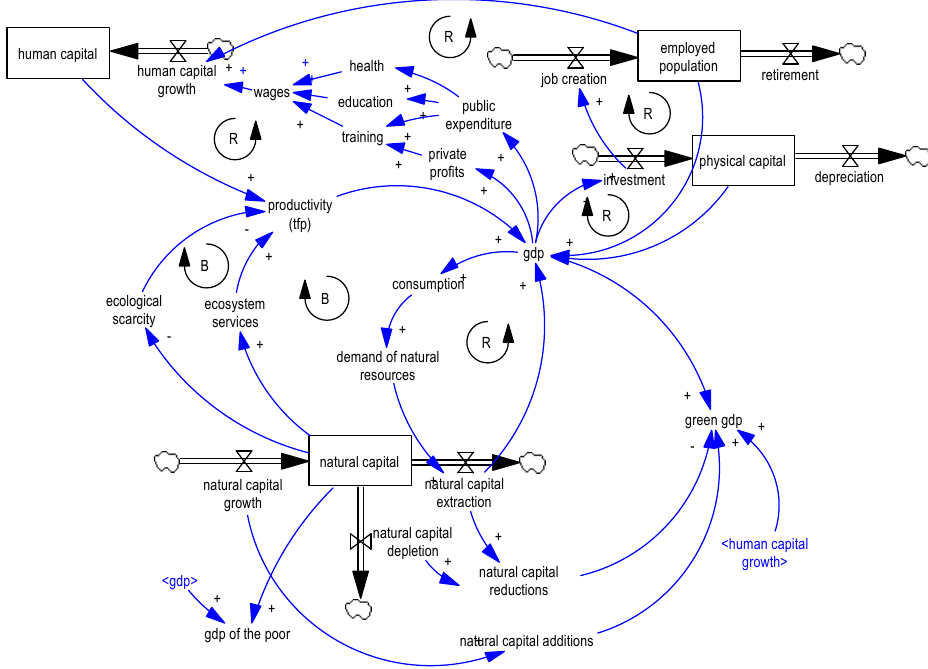
Fig. 1: Causal Loop Diagram (CLD) representing the main variables and feedback loops of GEM